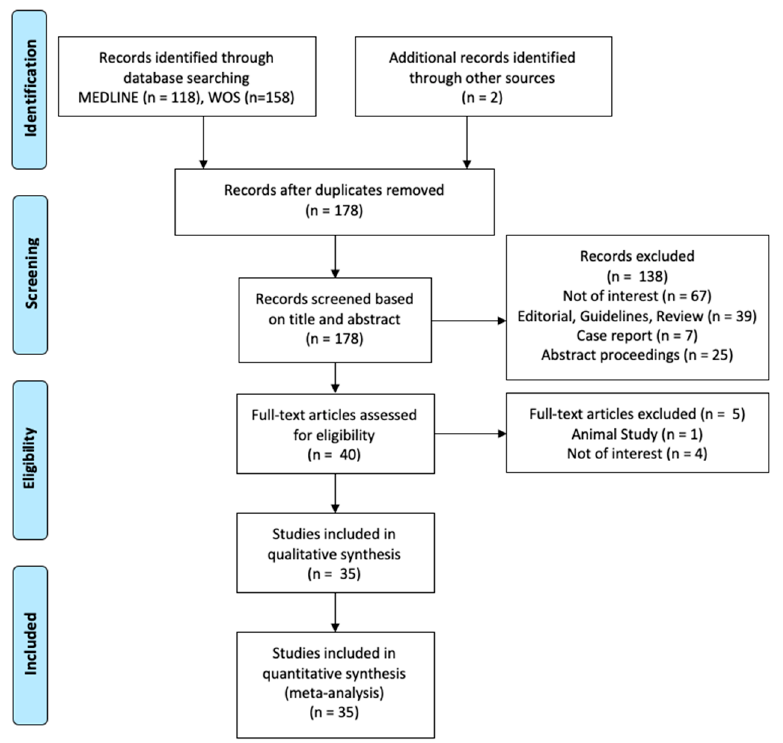
Figure 2. Preferred Reporting Items for a Systematic Review and Meta-analysis of Diagnostic Test Accuracy (PRISMA-DTA) flow diagram to select studies to be included in the subsequent meta- analysis.